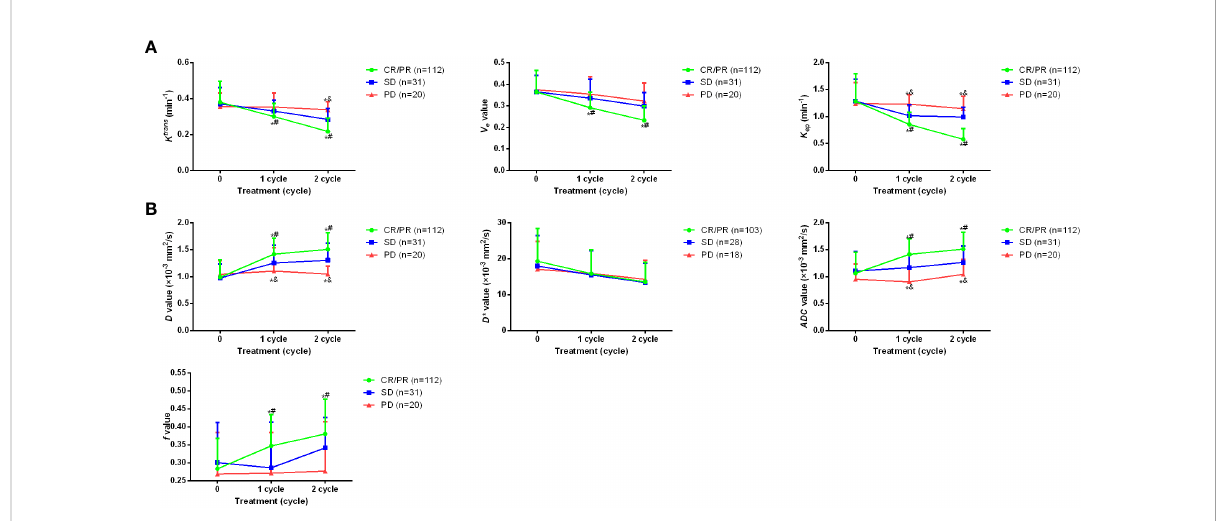
FIGURE 2 Dynamic alteration of imaging parameters for osteosarcoma patients with different clinical outcomes during treatment period. (A) K trans , K ep , and V e of DCE-MRI before treatment as well as after 1~2 cycles of the treatment. (B) changes of D , D* , ADC and f value of IVIM-DWI before treatment as well as after 1~2 cycles of the treatment. * p < 0.05 vs PD, # p < 0.05 vs SD, & p < 0.05 vs CR/PR. Comparison for continuous data were analyzed by t test (paired or unpaired) or Mann-Whitney U